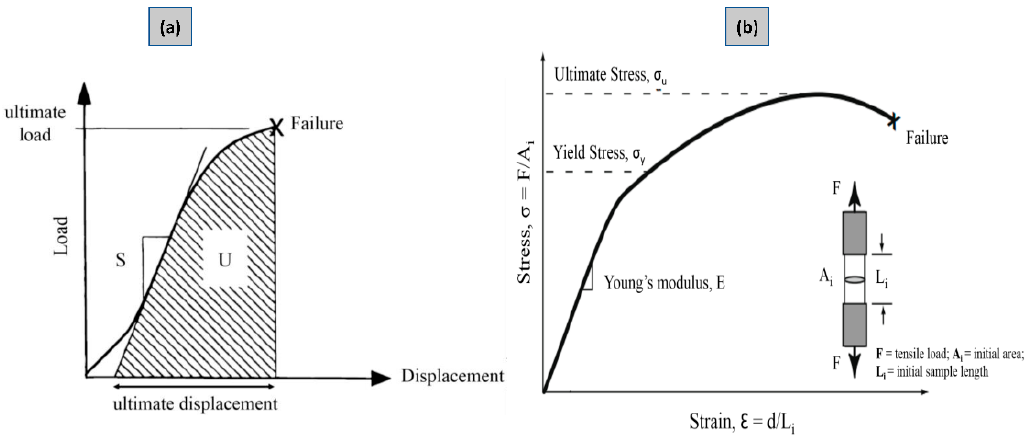
Figure 4. ( a ) Load-displacement curve; ( b ) tensile stress–strain curve of bone [21].